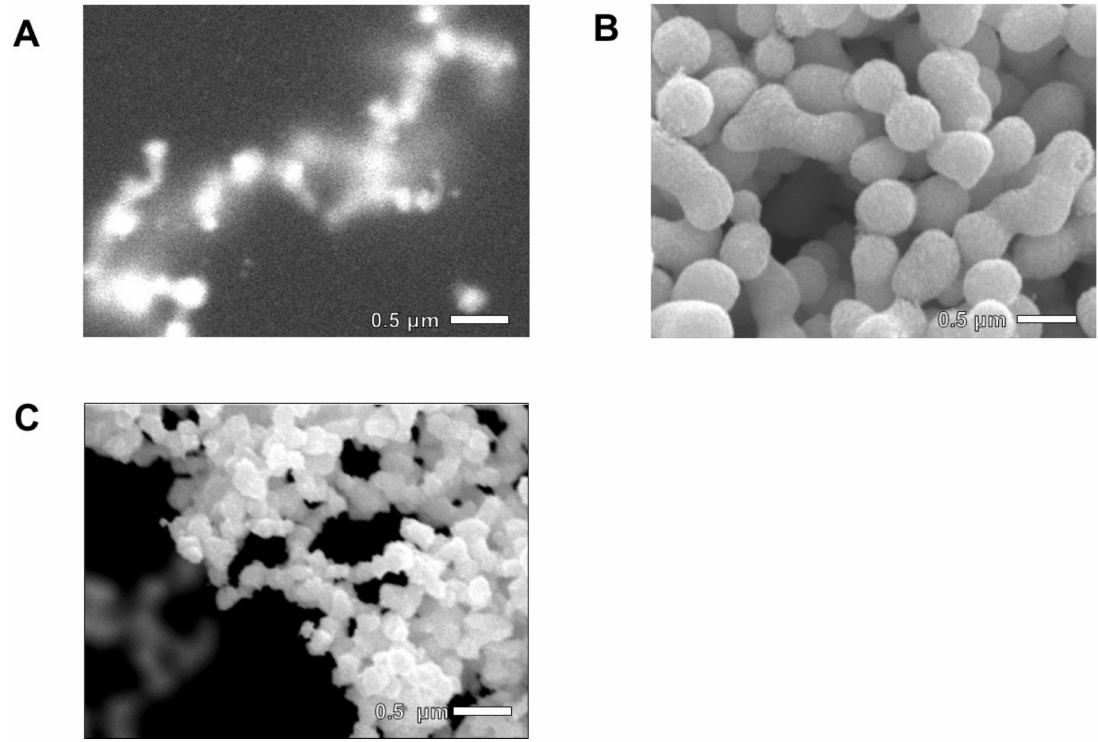
Figure 2. Images of 3D Pd-based nanostructures taken by ASEM and a traditional SEM. ( A ) ASEM image of Pd-based particles in liquid after 25 min of mixing. In the liquid phase, Pd-based particles formed lacelike network nanostructures. ( B ) Image of Pd-based particles after drying at 383 K for 24 h, taken by traditional SEM. Dried particles formed spherical shapes of micrometer size with smooth surfaces. ( C ) Image of Pd-based particles after critical point drying process taken by a traditional SEM. It is clearly shown that dried particles formed lacelike network